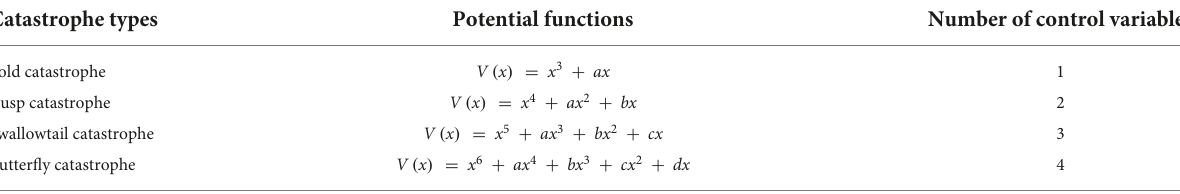
TABLE 2 Catastrophe types and normalization